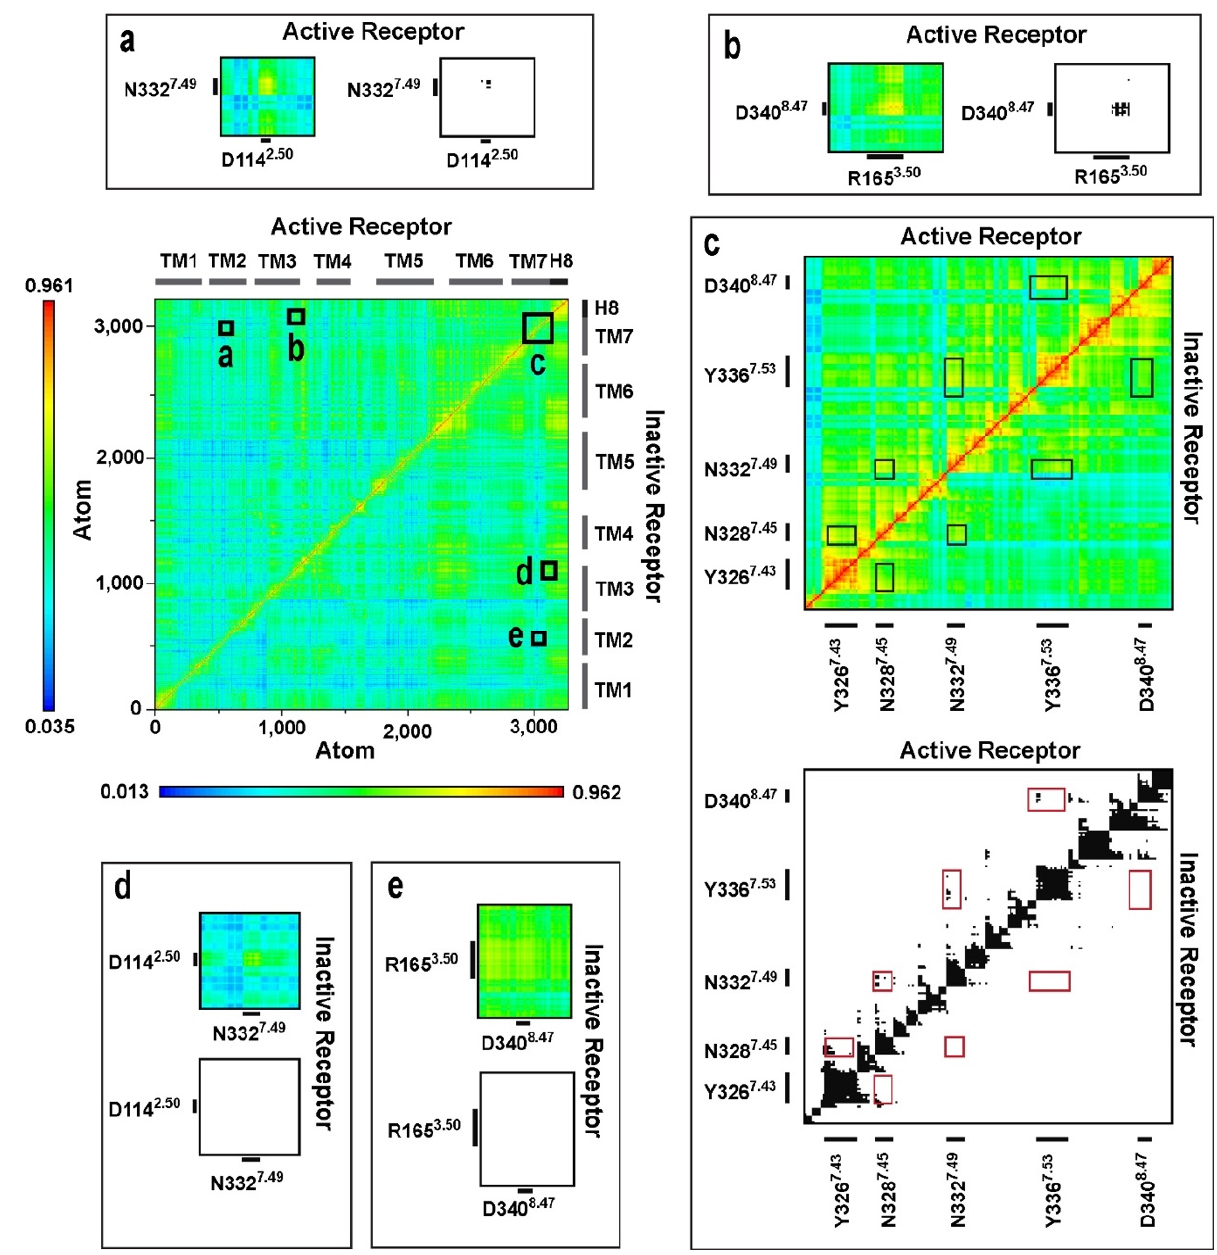
Figure 2. Dynamic cross-correlation matrices of the G i protein-bound MOP in active and inactive states. Panels ( a – e ) are magnified views of regions of amino acid residues of interest. Black and white panels show correlations above the threshold of 0.7 MI.